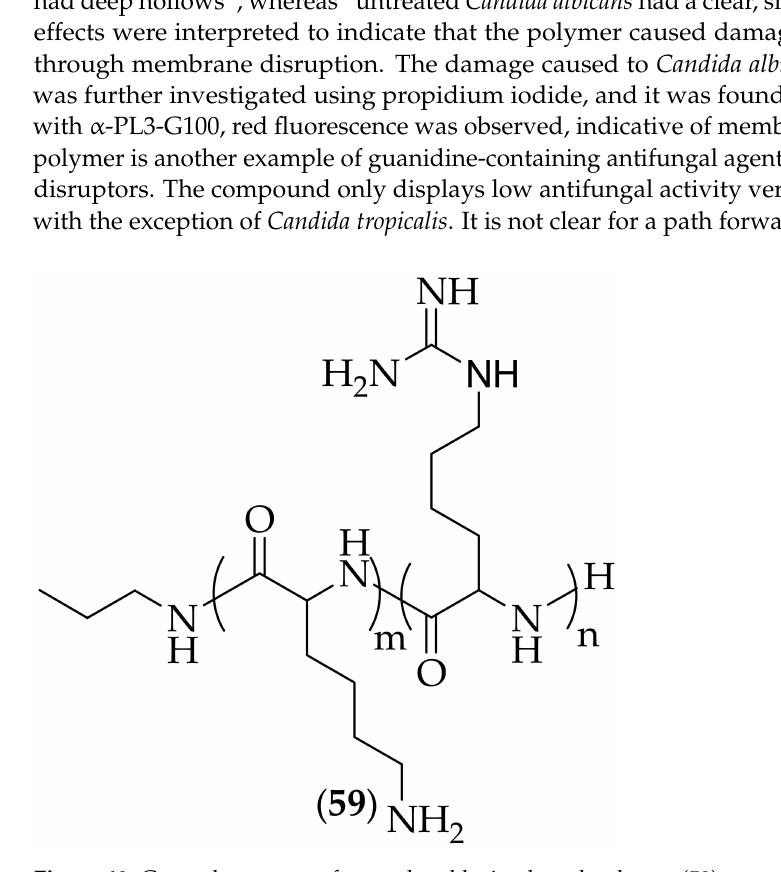
Figure 40. General structure of guanylated lysine-based polymer ( 59